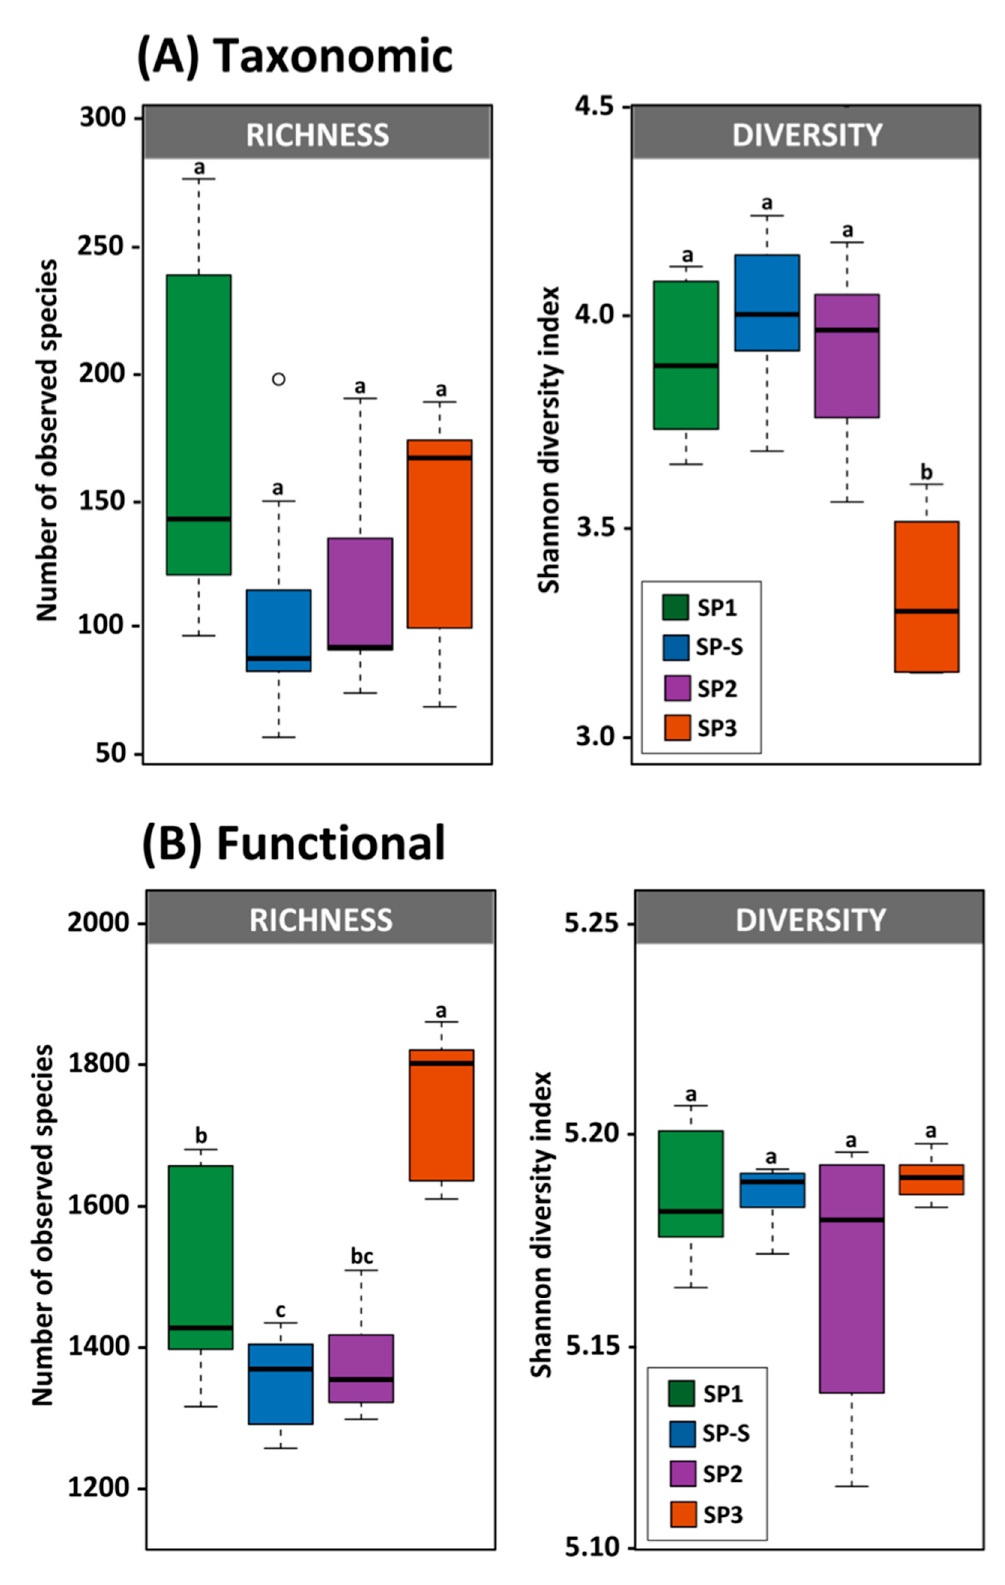
Figure 3. Diversity measurements of ( A ) taxonomic and ( B ) functional profiles based on DNA shotgun metagenome analysis. Different lowercase letters refer to significant differences between treatments based on Tukey’s HSD test ( p < 0.05).